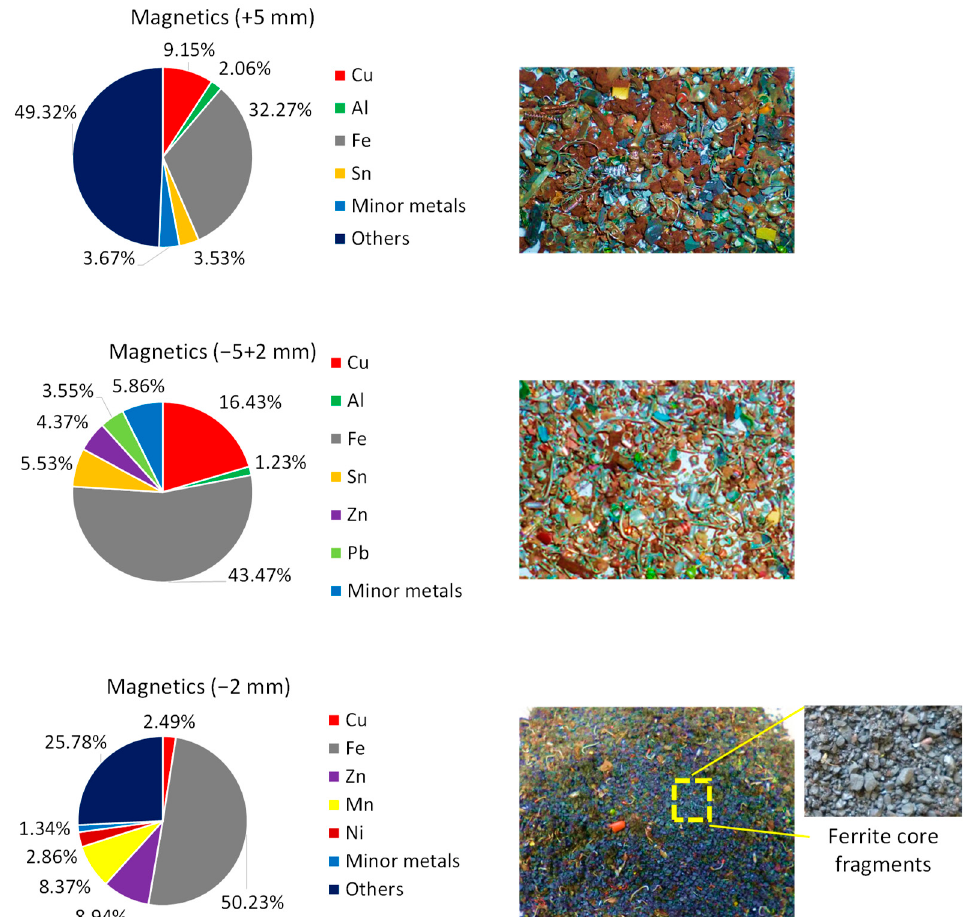
Figure 8. Elemental composition and pictures of the magnetic portion separated in the +2.8 g/cm³ fraction. “Minor metals” consider the sum of the elements Cu, Al, Fe, Sn, Zn, Pb, Ba, Mn, and Ni when not individually displayed. “Others” consider the sum of non-metallic elements and trace metals.